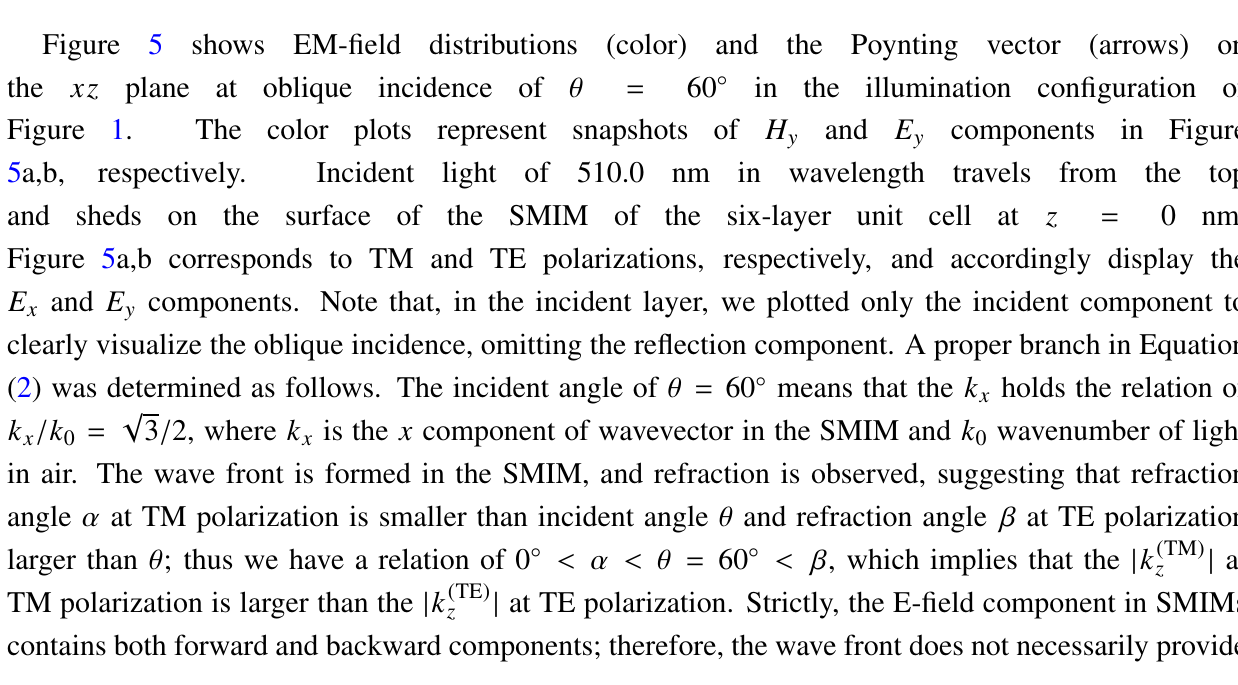
and E components y y